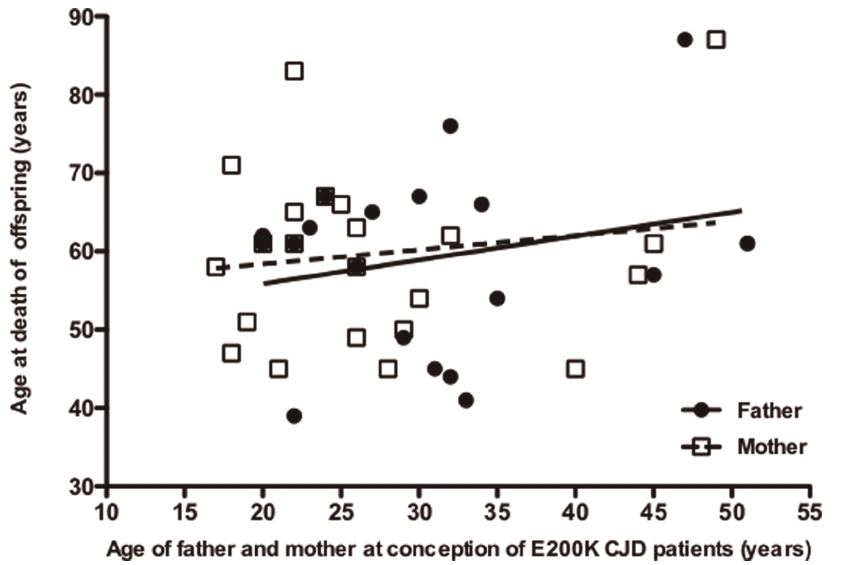
Figure 3. Father’s and mother’s age at conception versus age at death of offspring. The solid (father) and dashed (mother) lines denote the linear fit of data.